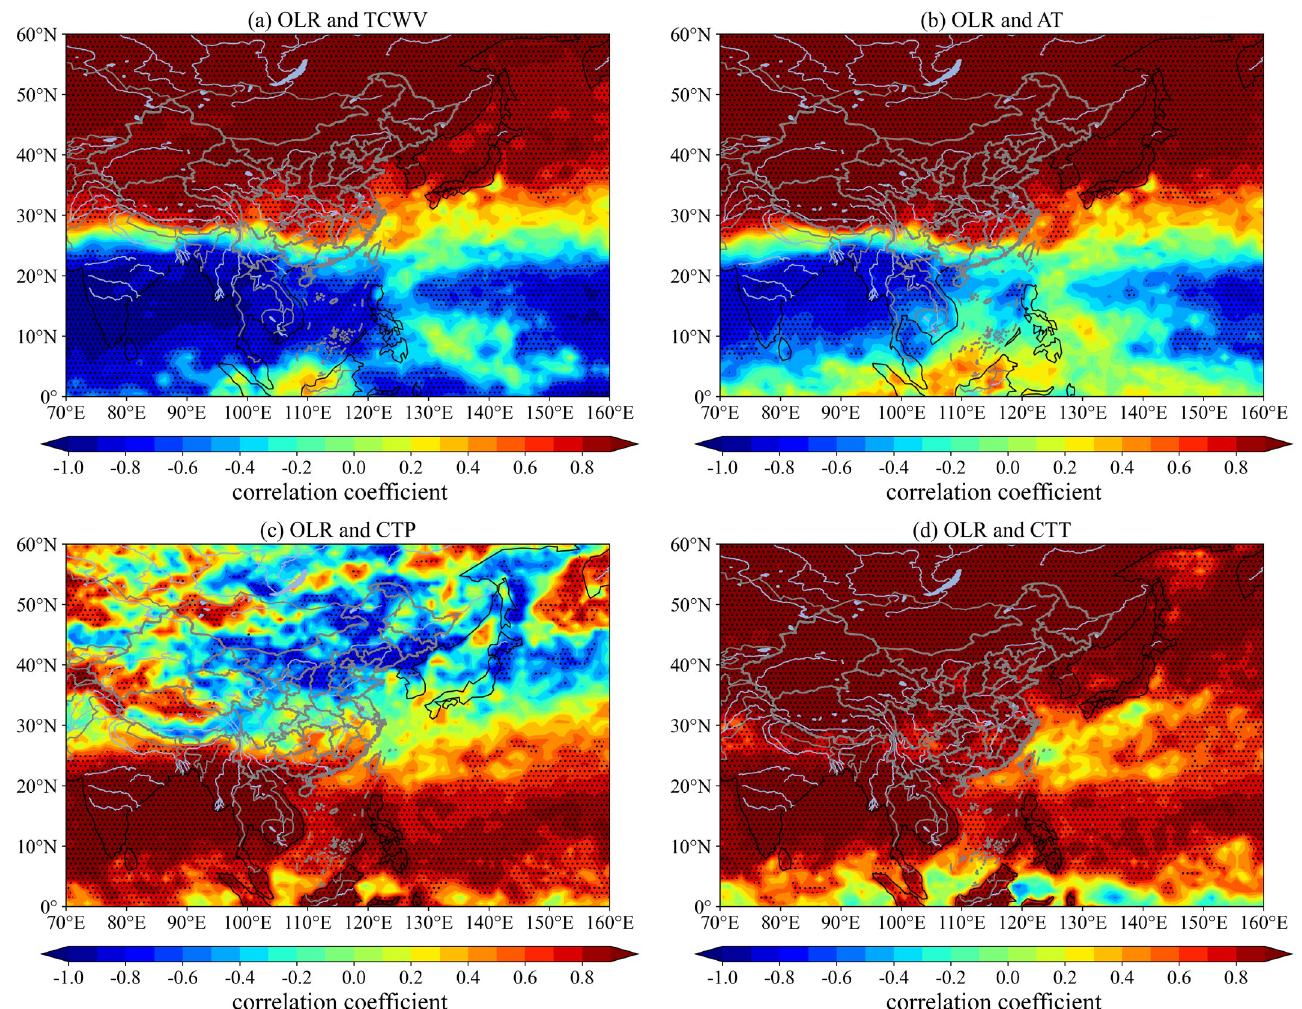
Figure 10. The longitude–latitude distributions of correlation between OLR and various factors; the black dots indicate that they passed the 99% significance test. ( a ) OLR and TCWV. ( b ) OLR and AT. ( c ) OLR and CTP. ( d ) OLR and CTT.